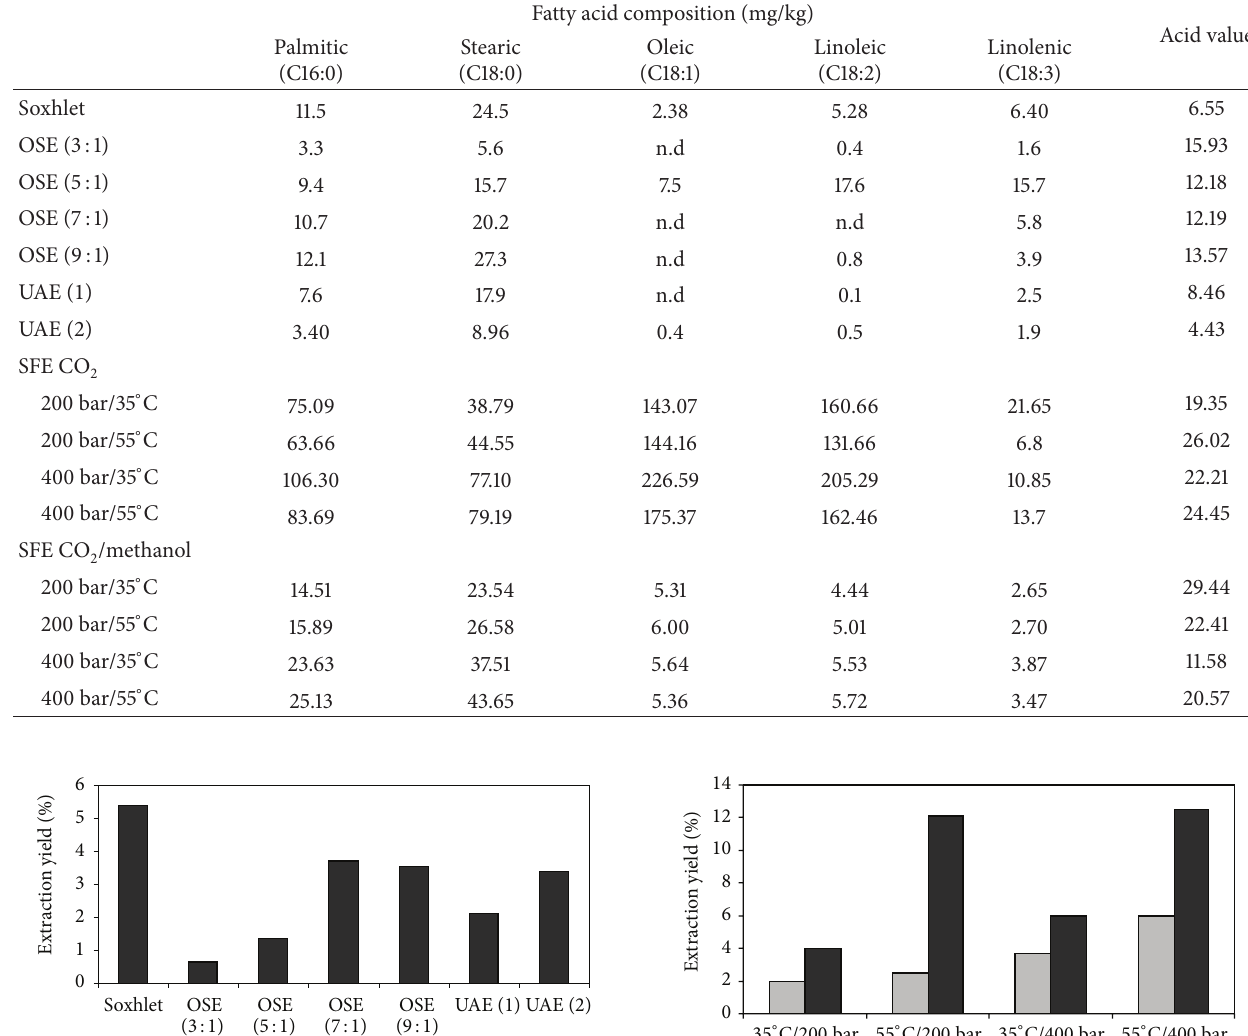
Table 1: Fatty acid concentrations and acid values of the extracts obtained by Soxhlet, OSE, UAE, and SFE. Fatty acid composition (mg/kg)